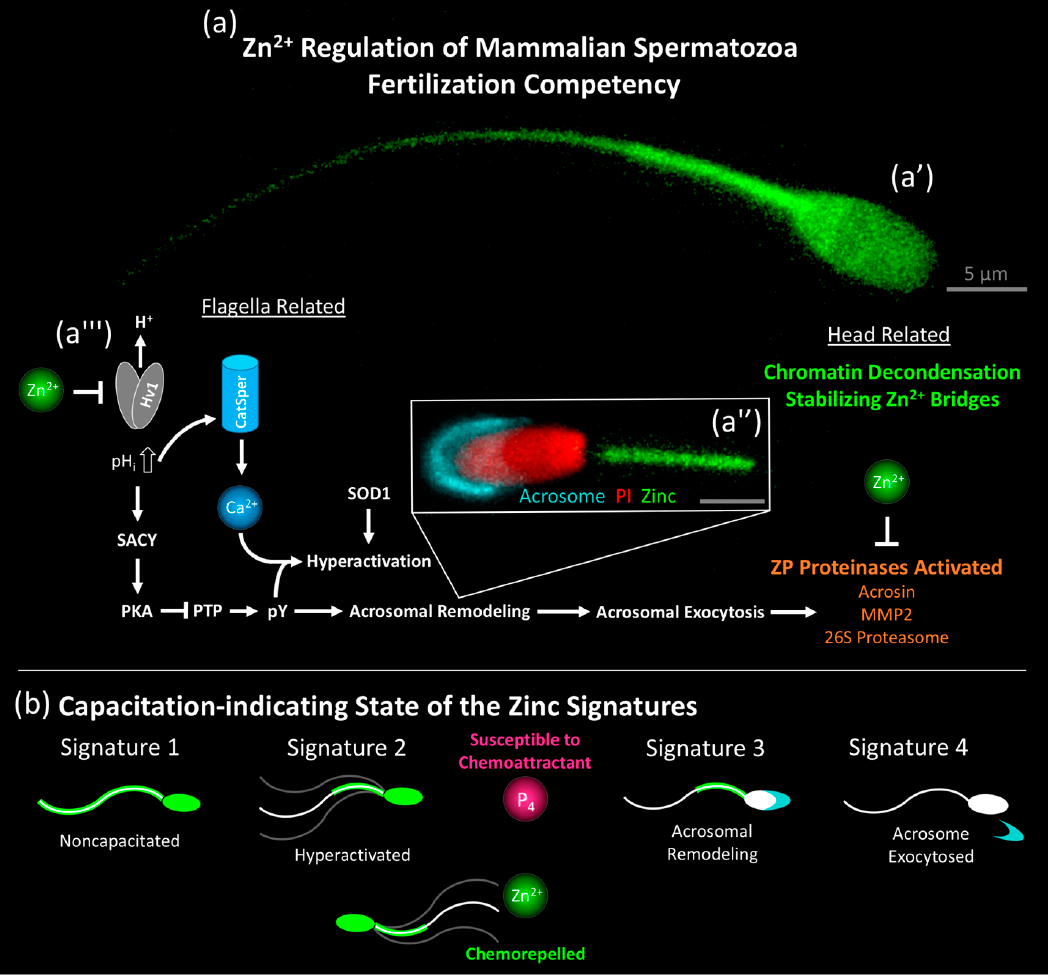
Figure 1. Summary of Zinc (Zn) signatures and free zinc ion (Zn 2+ ) regulation of the fertilization competency of mammalian spermatozoa. ( a ) Super-resolution images of the non-capacitated boar sperm Zn signature 1 ( a’ ) and acrosome-remodeled sperm Zn signature 3 ( a'' ) acquired by the Leica TCP SP8 stimulated emission depletion (STED) microscope (free zinc ions in green, outer acrosomal membrane in cyan, remodeled sperm head plasma membrane in red; scale bars in gray: 5 µm). ( a''') High Zn 2+ concentration (2 mM) negatively regulates proton channel Hv1, responsible for the rise of intracellular pH, facilitating: 1) Ca 2+ entry via CatSper and 2) protein tyrosine phosphorylation (pY), triggered by activation of soluble sperm adenylyl cyclase (SACY), increasing intracellular cAMP, activating protein kinase A (PKA) and phosphorylating protein tyrosine phosphatases (PTP) to an inactive state. For general capacitation pathway, review see Kerns et al., [144]). Following acrosome remodeling and exocytosis, zona pellucida (ZP) proteinases (acrosin, MMP2, and the 26S proteasome) implicated in endowing the spermatozoon with the ability to penetrate the ZP are activated. Zn 2+ , abundantly present in the fertilizing sperm triggered oocyte zinc shield, negatively regulates proteinase activities of spermatozoa bound to the zona or present in the perivitelline space, de-capacitating spermatozoa and serving as a newly proposed anti-polyspermy defense mechanism. ( b ) Capacitation-indicating state of the zinc signatures. Signature 1 spermatozoa are in a non-capacitated state. Signature 2 spermatozoa display hyperactivated motility. Only capacitating spermatozoa susceptible to progesterone (P 4 ) chemoattraction exhibit chemorepulsion by Zn 2+ . Signature 3 spermatozoa exhibit acrosome remodeling while acrosomal exocytosis reportedly occurs in signature 4. 5. Effect of Zinc Supplementation on Male Fertility Reduced seminal fluid Zn 2+ has been reported in cases of male infertility that are associated with accidental Chernobyl radiation in Ukraine [156], signifying a possible relationship between Zn 2+ and male fertility. Indeed, seminal fluid Zn 2+ concentration is positively correlated with sperm count and normal sperm morphology [157]. Consequently, Zn 2+ supplementation improves sexual dysfunction in rats [158] and uremic men [159], which is likely due to the ability of Zn 2+ to increase